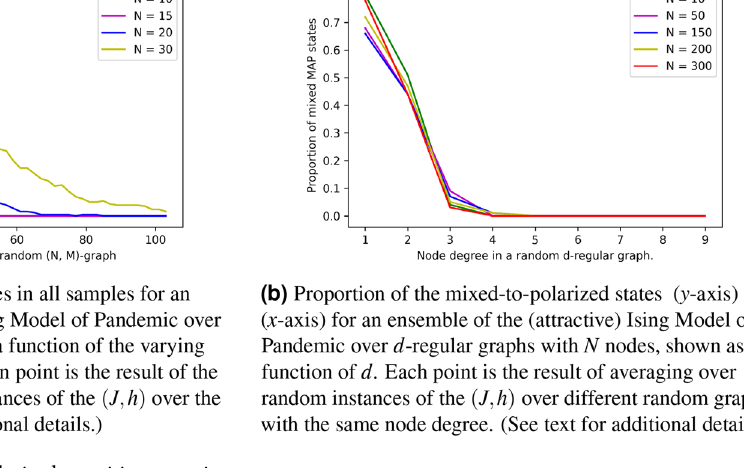
Figure 3. Mixed-to-polarised transition